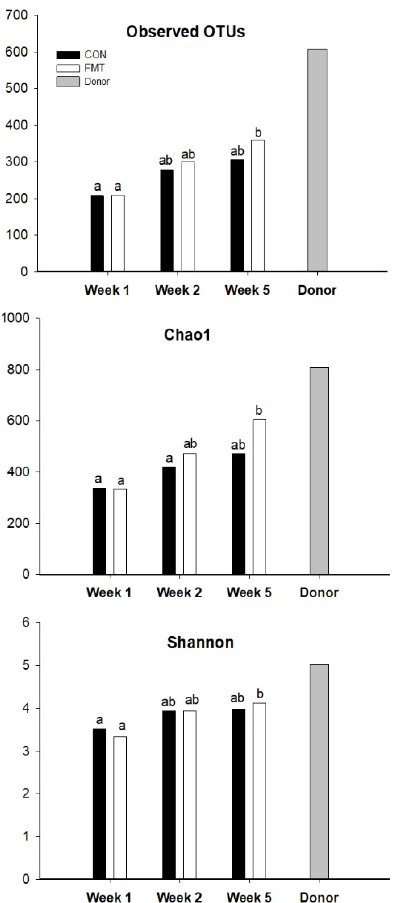
Figure 3. Mean values for alpha diversity indices across groups investigated in this study and donor sample. Alpha diversity indices that show a statistically significant difference ( p < 0.05) across means are based on the Kruskal-Wallis rank sum test. This analysis did not include the Donor because it was a single sample. ab Different superscripts indicate that groups are significantly different by the Wilcoxon pairwise test. Chao1 = estimation of the OTUs abundance in samples. Shannon = indicates the diversity of the OTUs in samples.